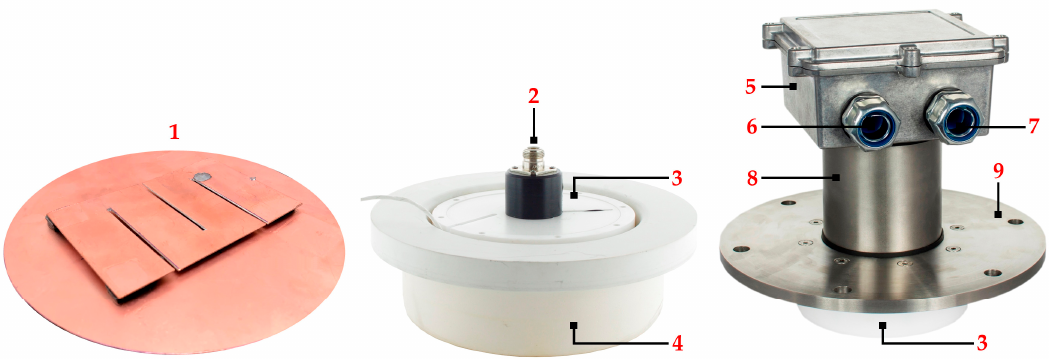
Figure 8. Components of the ISO-002-ADW/UHF sensor: 1 = meandered PIFA, 2 = N-type connector, 3 = cylindrical PTFE-housing, 4 = active dielectric window, 5 = enclosure for partial discharge (PD) pulses conditioning module and analog-to-digital processing module, 6 = fiber optic cable gland, 7 = cable gland for power supply, 8 = shielding tube for signal cables, 9 = inspection hole cover.